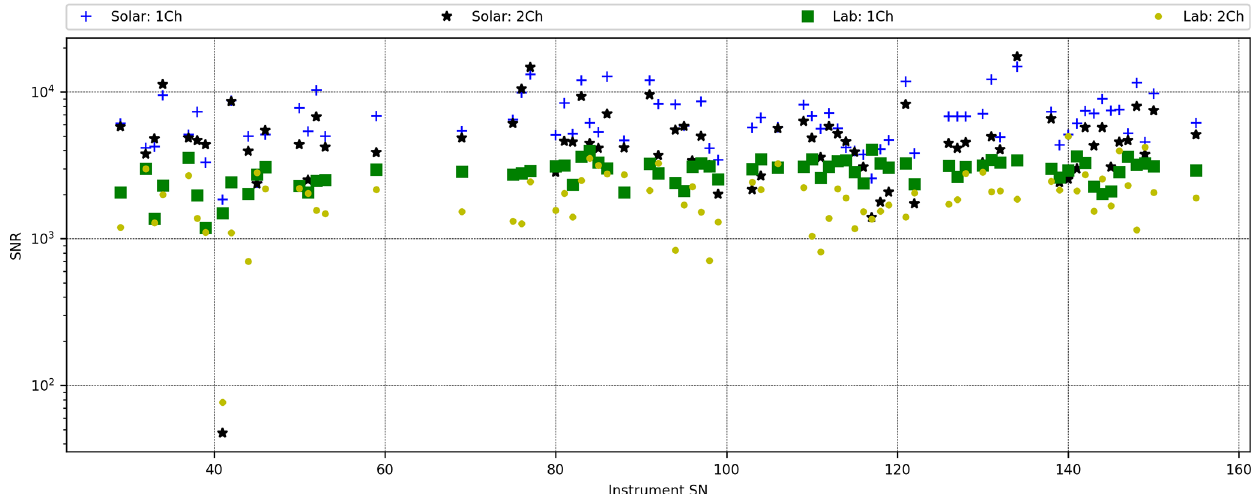
Figure 25. Instrumental distribution of the SNR for both channels with both kinds of measurements: solar and OP in the laboratory.